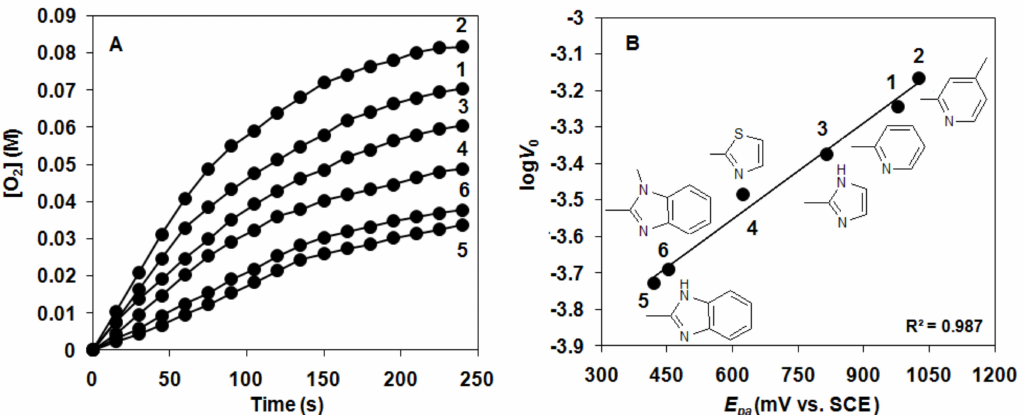
Figure 6. Kinetic analysis for the hydrogen peroxide degradation catalyzed by [Mn II (HL 1–6 )Cl 2 ] ( 1 – 6 ) complexes in bicarbonate bu ff er (pH = 9.6). ( A ) Time traces for the reaction of [Mn II (HL 1–6 )Cl 2 ] ( 1 – 6 ) complexes with H 2 O 2 in the presence of bicarbonate. ( B ) Dependence of the reaction rate on the oxidation potential ( E pa ) of the [Mn II (HL 1–6 )Cl 2 ] complexes for the [Mn II (HL 1 )Cl 2 ]-catalyzed disproportionation of H 2 O 2 . Conditions: [1–6] 0 = 2.11 × 10 − 4 M, [H 2 O 2 ] 0 = 4.47 × 10 − 1 M at 20 ◦